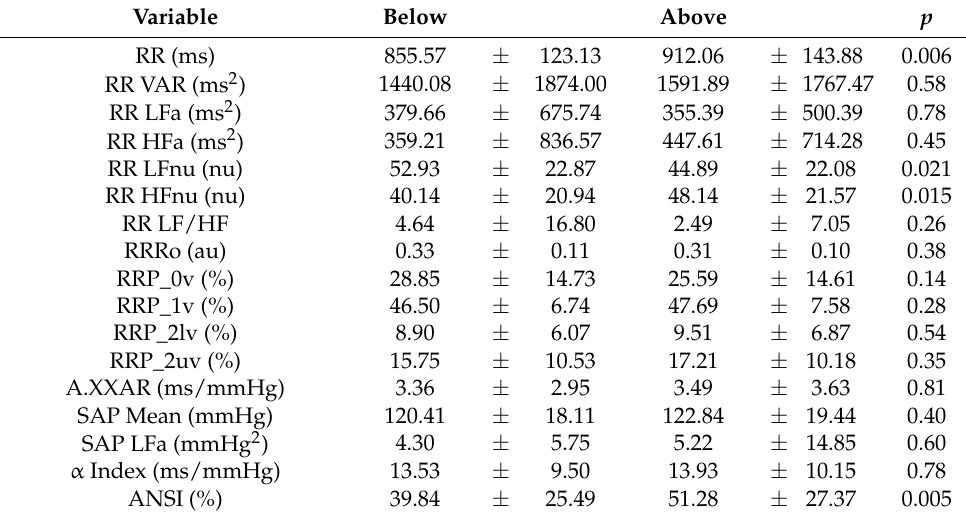
Table 2. Values of cardiac autonomic proxies observed in patients whose weekly physical activity was below or above the current physical activity goals.